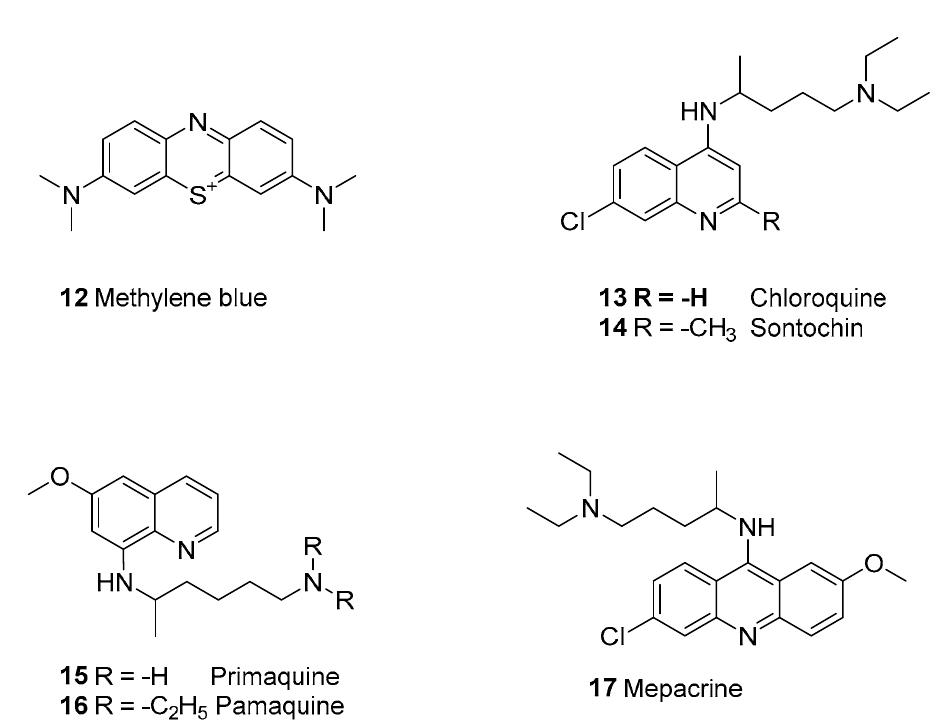
Figure 7. Early synthetic antimalarial drugs. Chloroquine and primaquine are included on WHO list of essential medicines (https://www.who.int/medicines/publications/essentialmedicines/en/, accessed on 1 April 2021).